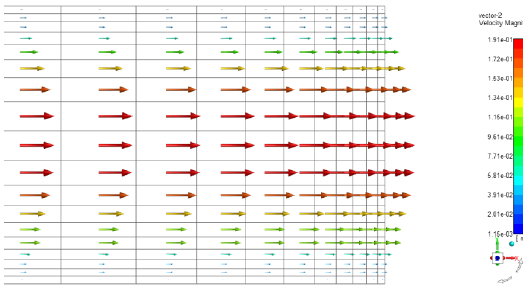
Fig. 10. Velocity magnitude profile parallel to XY plane (a side view from symmetry plane)